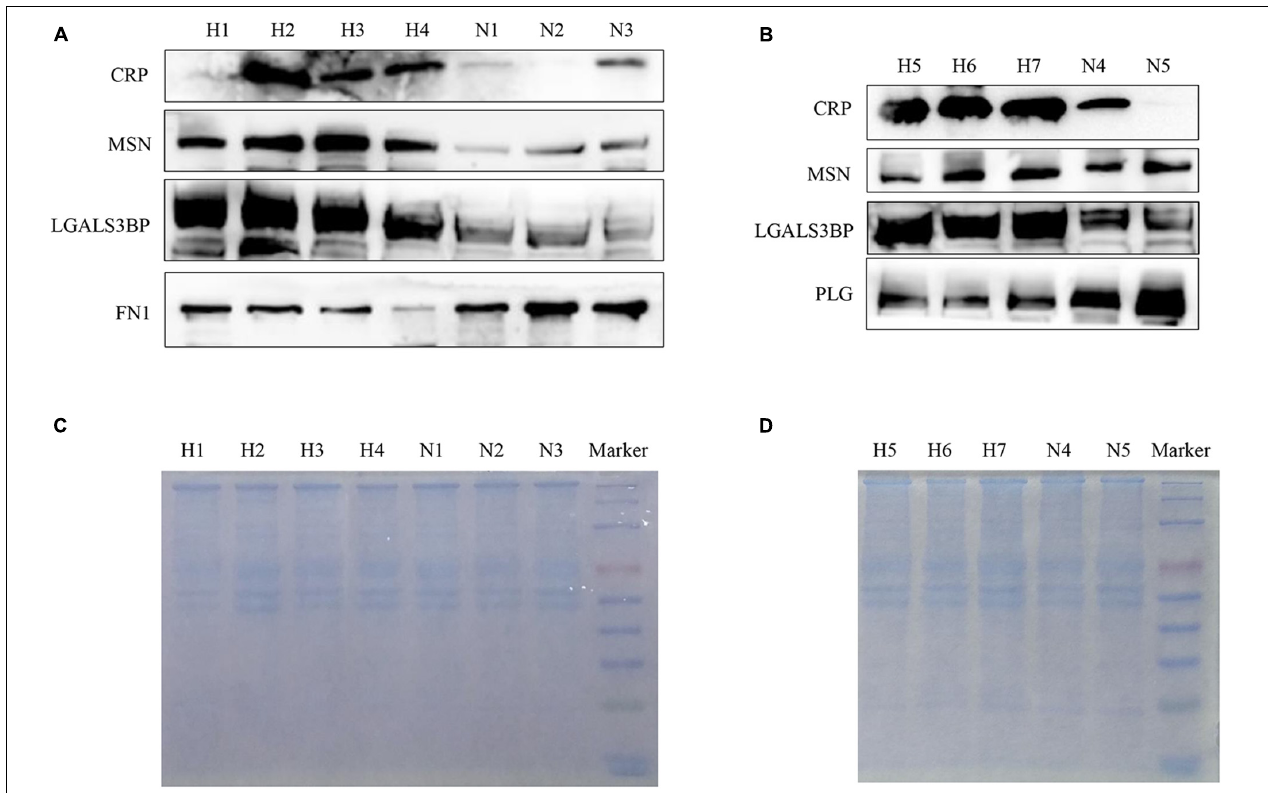
FIGURE 5 | Verification of differentially expressed proteins in plasma exosomes obtained from other patients with EBV-HLH by western blotting. (A,B) The expression level of differentially expressed proteins in plasma exosomes between the patients with EBV-HLH and healthy controls (H represents patients with EBV-positive HLH, N represents healthy controls). (C,D) The total protein loading amount of each sample in (A,B) was visualized by Coomassie brilliant blue